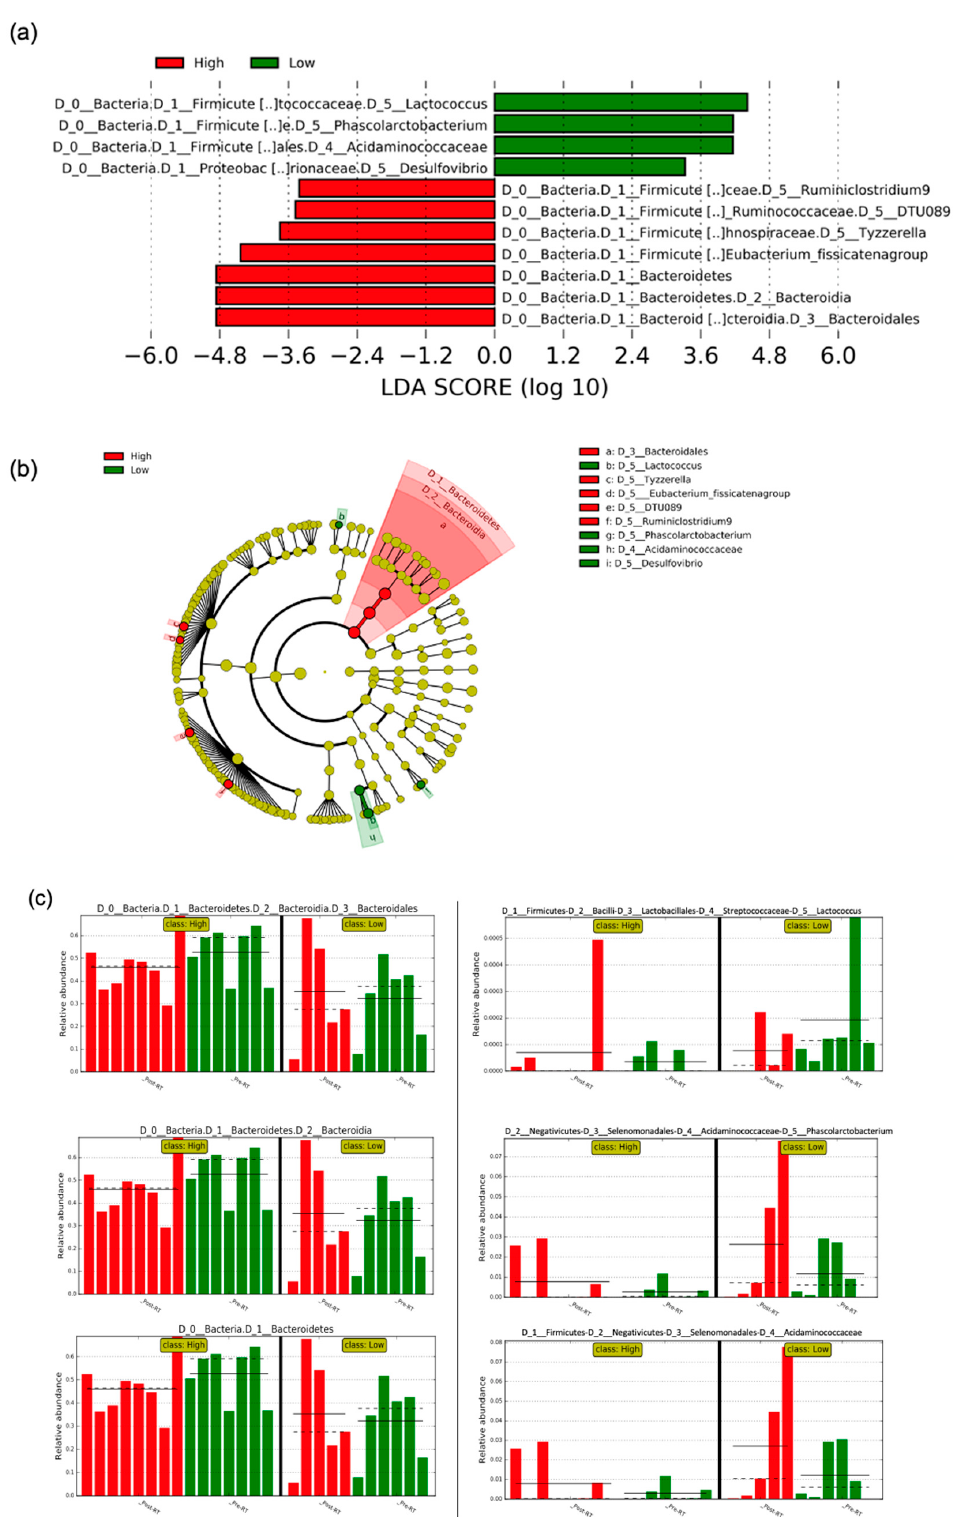
Figure 3. Linear discriminant analysis (LDA) effect size (LEfSe) for the gut microbial abundance based on PNS levels (low vs. high). ( a ) shows the overabundant taxa for low vs. high PNS, ( b ) shows the cladogram of taxa associated with PNS, and ( c ) shows the three most significant biomarkers of high (left panel) vs. low (right panel) PNS by time (pre-RT vs. post-RT); the solid straight lines mean plot subclass means; the dotted straight lines mean plot subclass medians. Low indicates low PNS level; High indicates high PNS level. PNS, psychoneurological symptoms; RT, radiation therapy.